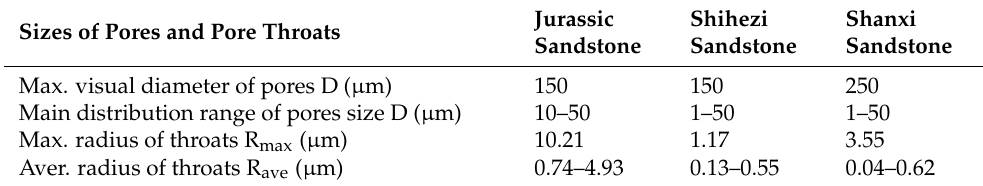
Jurassic Shihezi Shanxi Sandstone Sandstone Sandstone